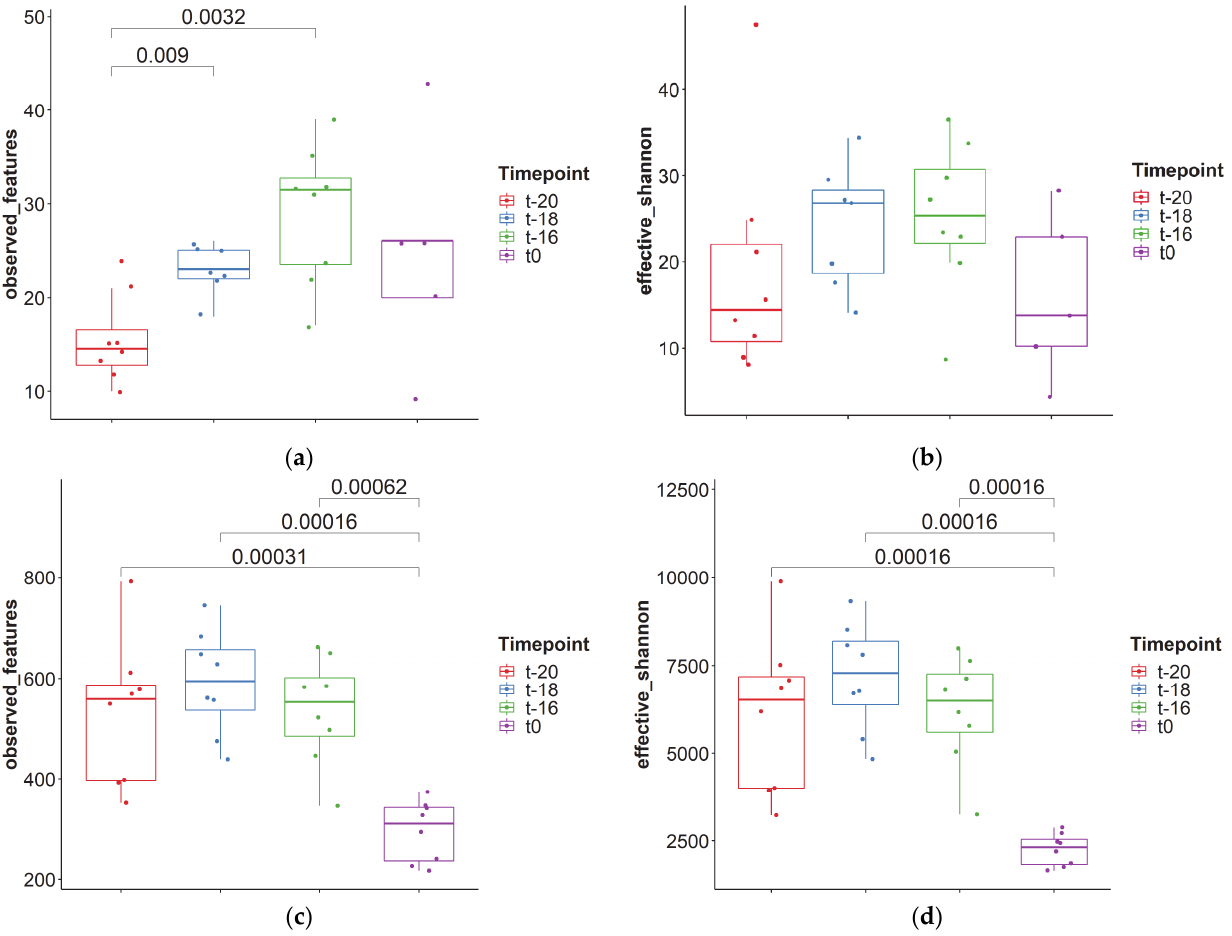
Figure 1. Alpha ‐ diversity of the lumen samples during the adaptation period. ( a ) Observed fea ‐ Figure 1. Alpha-diversity of the lumen samples during the adaptation period. ( a ) Observed features tures of fungi; ( b ) Shannon ‐ diversity ‐ index fungi; ( c ) observed features bacteria; ( d ) Shannon ‐ di ‐ of fungi; ( b ) Shannon-diversity-index fungi; ( c ) observed features bacteria; ( d ) Shannon-diversity- versity ‐ index bacteria; significant pairwise comparisons are shown (Wilcoxon signed ‐ rank test). index bacteria; significant pairwise comparisons are shown (Wilcoxon signed-rank